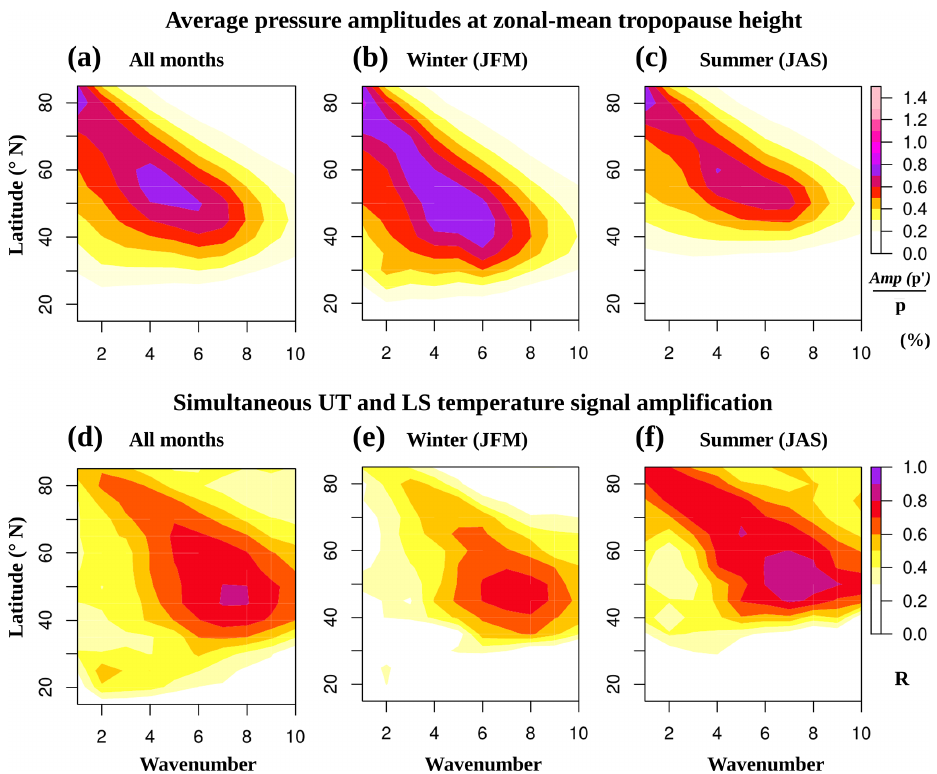
Figure 3. (a–c) Wave activity spectra, as the mean amplitude of the filtered pressure anomalies at the zonal-mean tropopause level for (a) the whole 2007–2016 series, (b) winter and (c) summer months. (d–f) Simultaneous amplification of the LS and UT temperature signals, as the correlation of their amplitude time series for (d) all, (e) winter and (f) summer